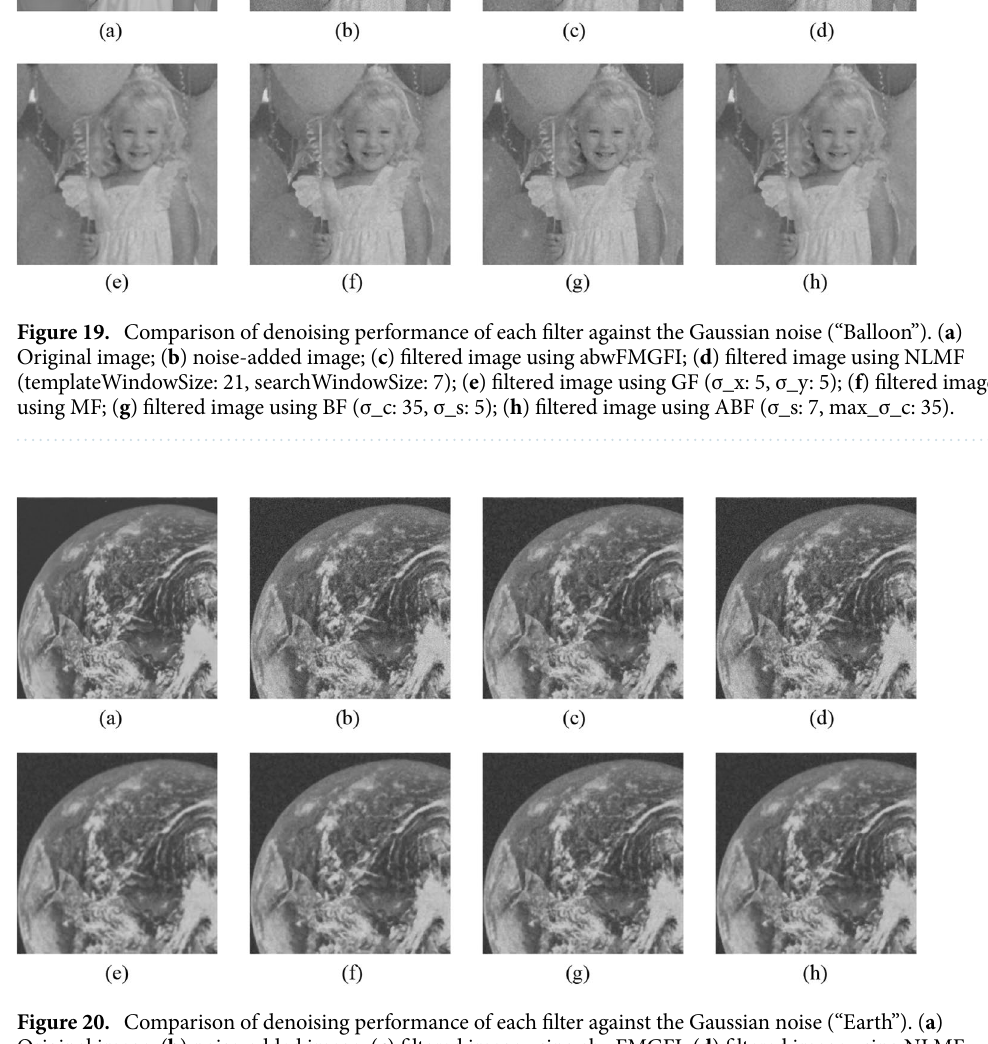
Figure 20. Comparison of denoising performance of each filter against the Gaussian noise (“Earth”). ( a ) Original image; ( b ) noise-added image; ( c ) filtered image using abwFMGFI; ( d ) filtered image using NLMF (templateWindowSize: 21, searchWindowSize: 7); ( e ) filtered image using GF (σ_x: 5, σ_y: 5); ( f ) filtered image using MF; ( g ) filtered image using BF (σ_c: 35, σ_s: 5); ( h ) filtered image using ABF (σ_s: 7, max_σ_c: